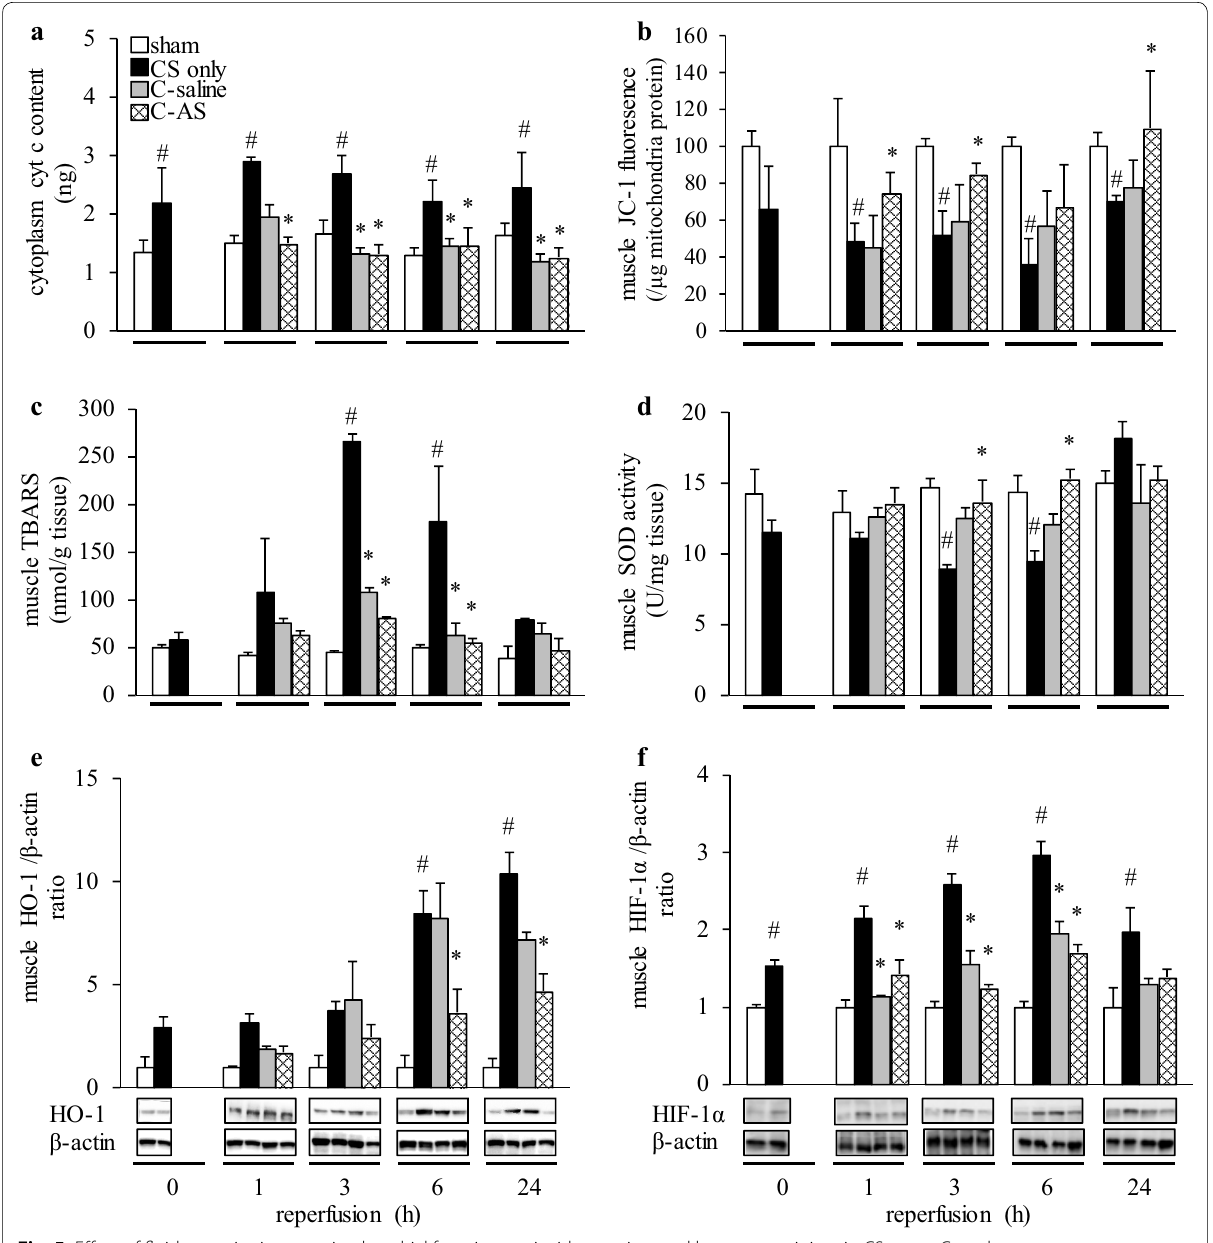
Fig. 5 Effect of fluid resuscitation on mitochondrial function, antioxidant action, and low-oxygen injury in CS rats. a Cytoplasm cyt c content, b muscle JC-1 fluorescence, c muscle TBARS ratio, d muscle SOD activity, e muscle HO-1/β-actin ratio, and f muscle HIF-1α/β-actin ratio. White bar sham, black bar CS-only, gray bar C-saline and, shaded bar C-AS. Values represent mean versus CS-only group, and † p < 0.05 versus C-saline group (Tukey’s test). CS crush syndrome, cyt c cytochrome c , TBARS thiobarbituric acid reactive substances, SOD superoxide dismutase, HO-1 heme oxygenase-1, HIF-1α hypoxia-inducible factor-1